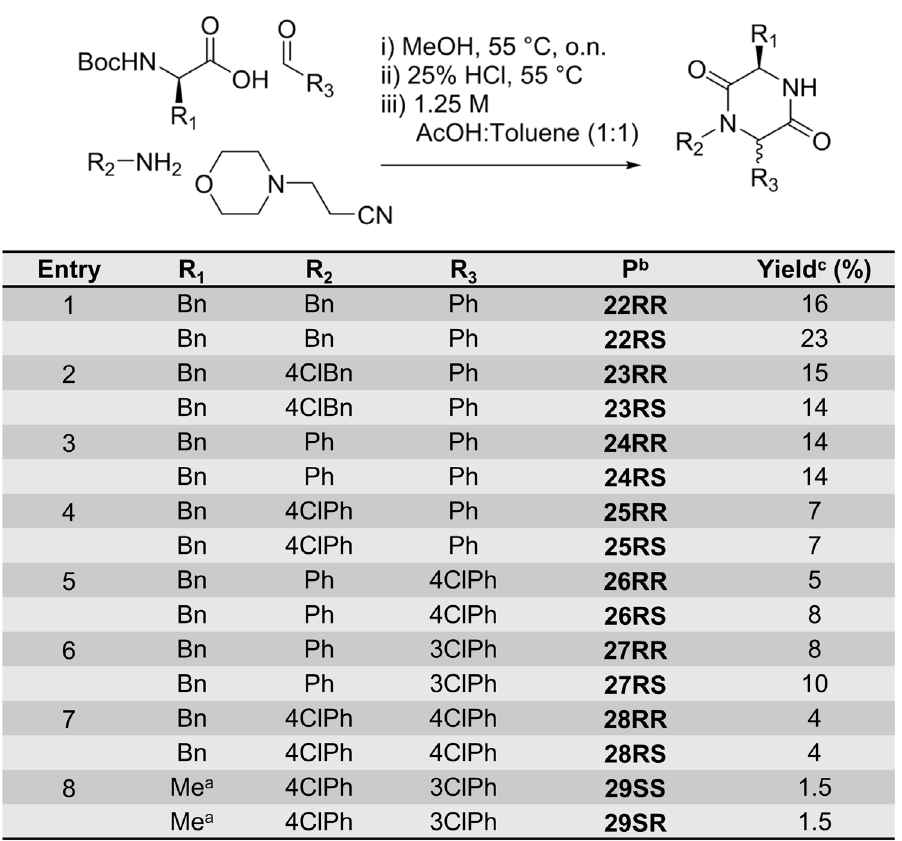
Fig 9. Synthesis of non-spiro-DKPs 22 –